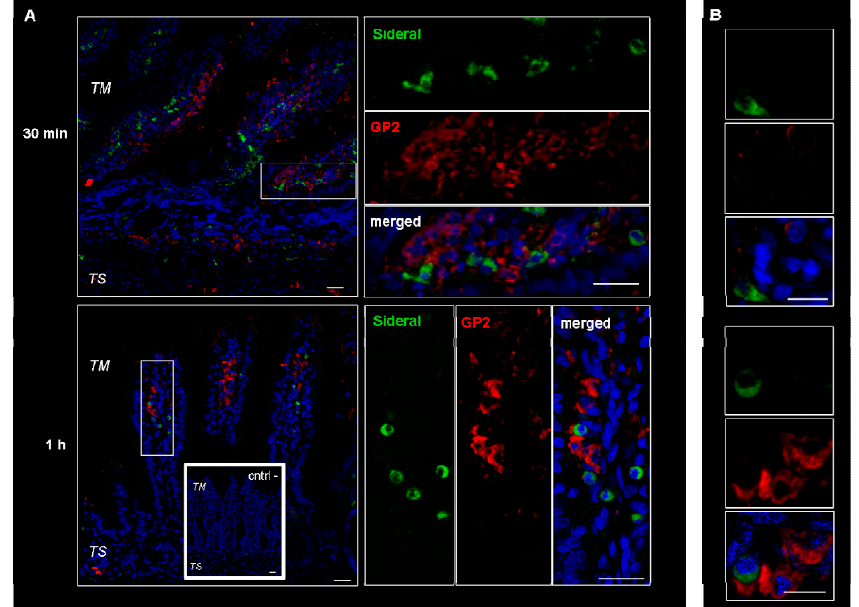
Figure 4 . Confocal laser scanning microscopy: representative images of rat gut sections after 0.5 and 1 h incubation in Ussing chamber. Negative controls obtained omitting primary antibodies are shown in double line squares. Individual fluorescent channels: green (SRM), red (GP2 + cells) and blue (nuclei). ( A ) bidimensional image of the maximum intensity projection. Scale bar 25 µm. ( B ) Images acquired in one Z-plane (38th of 59, 22nd of 64, incubated 0.5 h and 1 h, respectively) at a higher magnification. Scale bar 10 µ